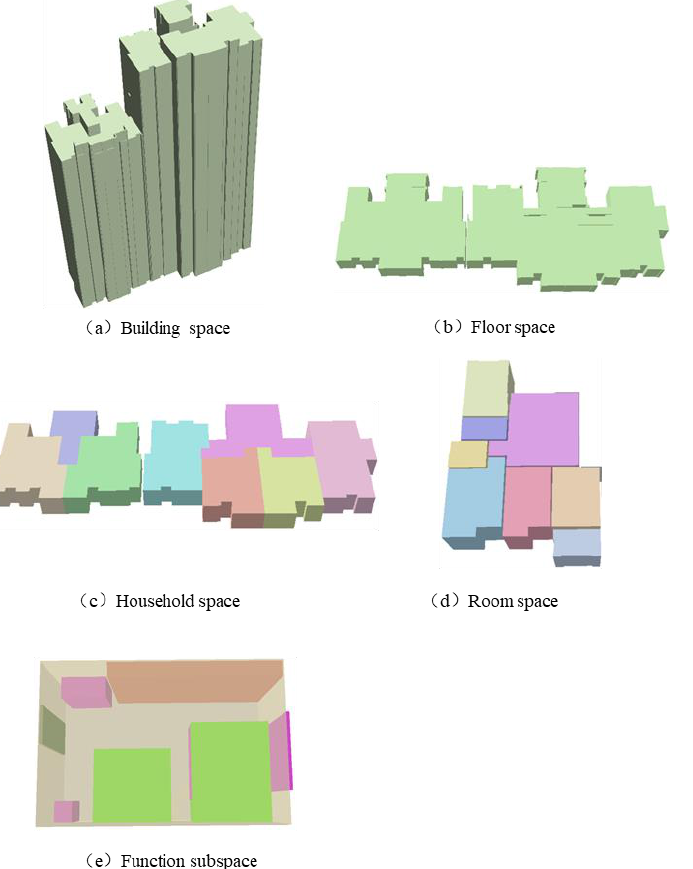
Figure 13. Demonstration of each level of indoor space.